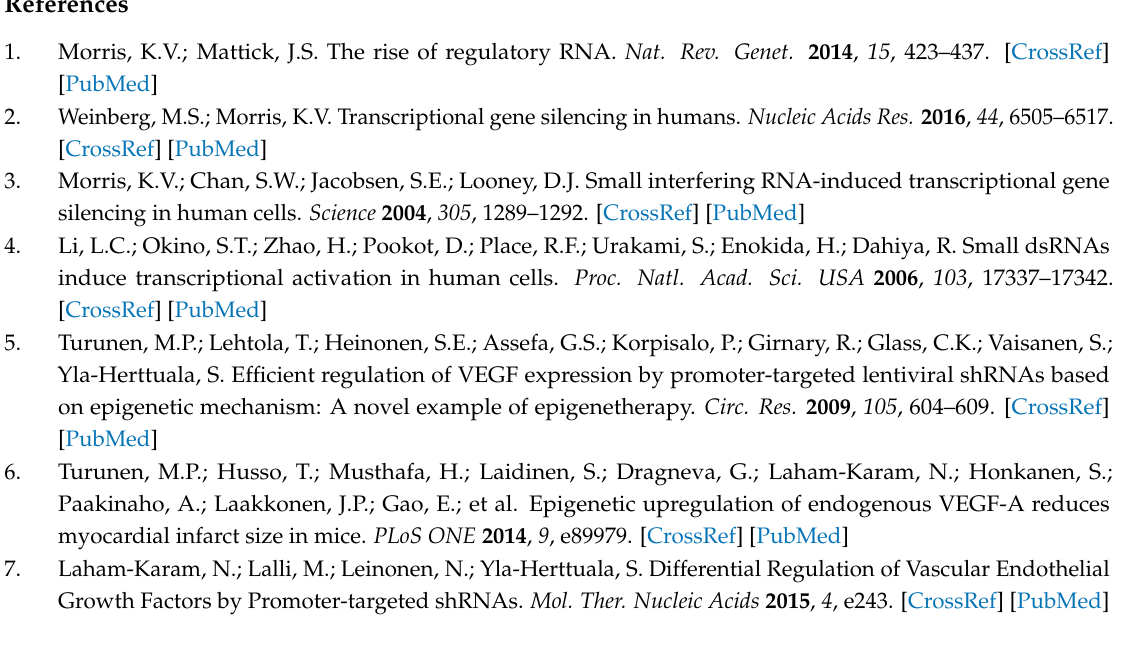
Supplementary Materials: The following are available online at http://www.mdpi.com/2311-553X/4/4/34/s1, Figure S1: VEGF-AS1 and VEGF-AS2 localize to the VEGF-A promoter in hypoxia; Figure S2: Repression of VEGF-AS1 results in the downregulation of VEGF-A expression in PC-3 cells; Table S1: The sequences of RP1-261G23.7 and EST AV731492; Table S2: Oligonucleotide and primer sequences. Author Contributions: Conceptualization, T.N., K.V.M., S.Y.-H. and Z.C.; Methodology, T.N., K.V.M.,